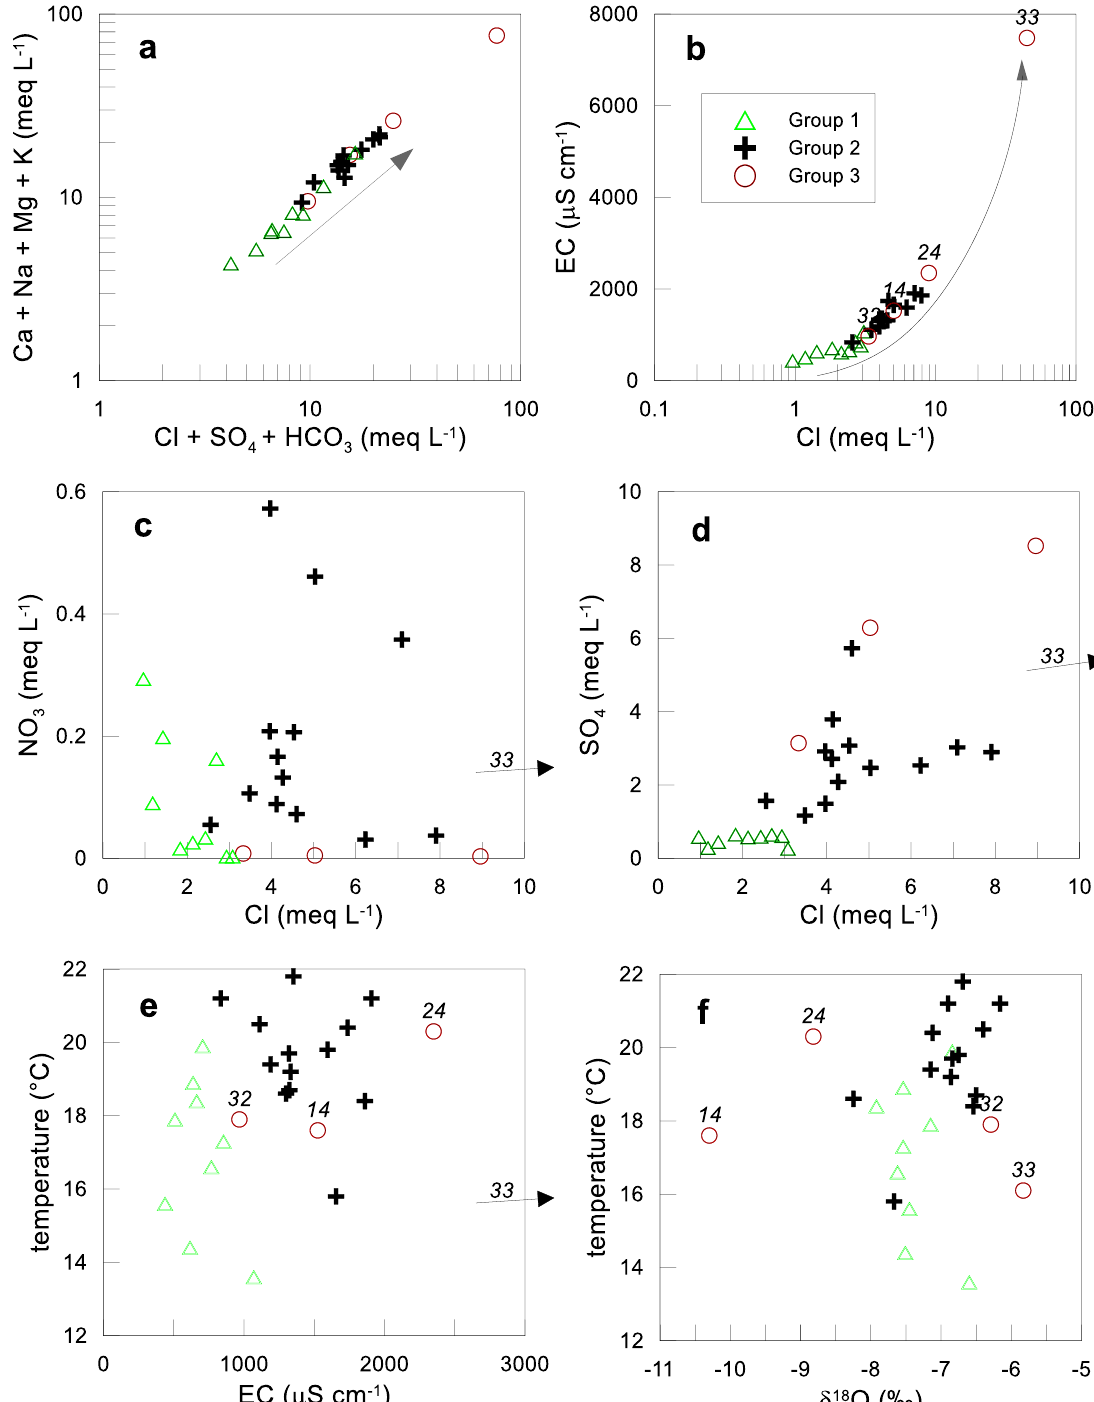
Figure 5. Scatter plots for evaluation of hydrogeochemical processes: ( a ) (Ca + Na + Mg + K) vs. (Cl + SO 4 + HCO 3 ); ( b ) EC vs. Cl; ( c ) NO 3 vs. Cl; ( d ) SO 4 vs. Cl; ( e ) salinity vs. temperature; ( f ) oxygen-18 vs. temperature.